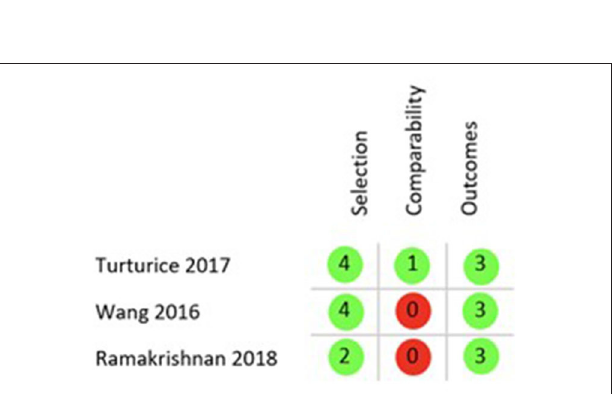
FIGURE 4 | NOS results quality appraisal of observational studies. NOS results of the three included cohort studies, two with an overall poor rating due to the lack of comparability between cohorts and one with a good